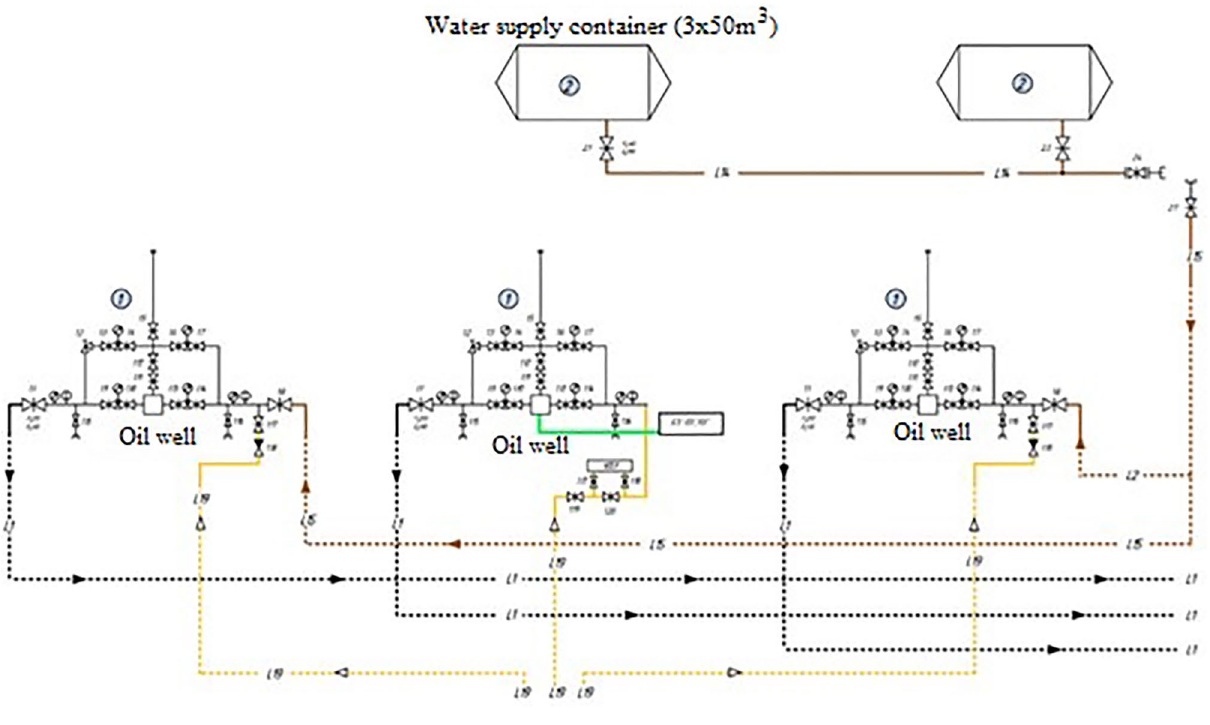
Figure 8. Proposed automation